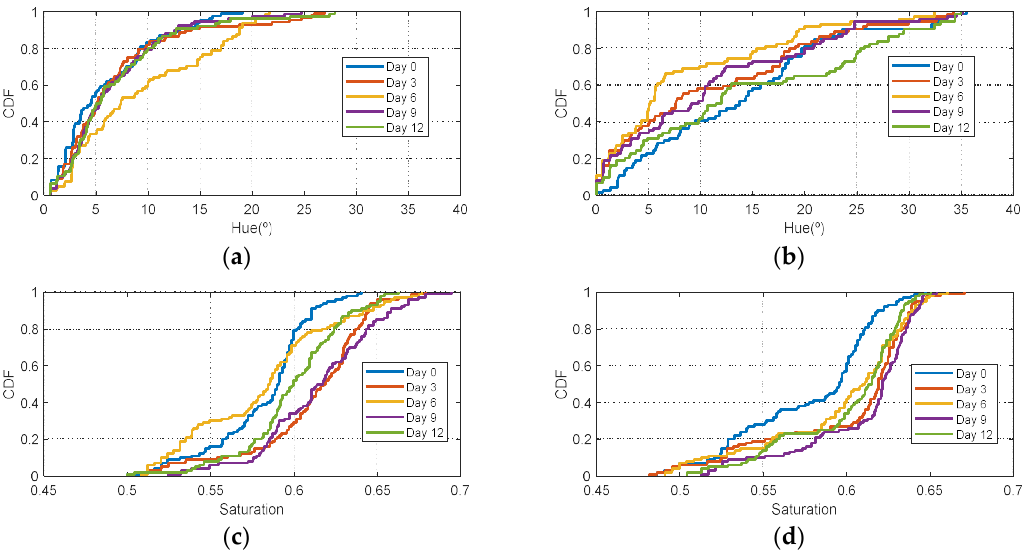
Figure 11. Cumulative Distribution Function (CDF) of the Hue parameter for the red apple in the fridge ( a ) and at room temperature ( b ) as a function of the number of days. Cumulative Distribution Function (CDF) of the saturation parameter for the red apple in the fridge ( c ) and at room temperature ( d ) as a function of the number of days.